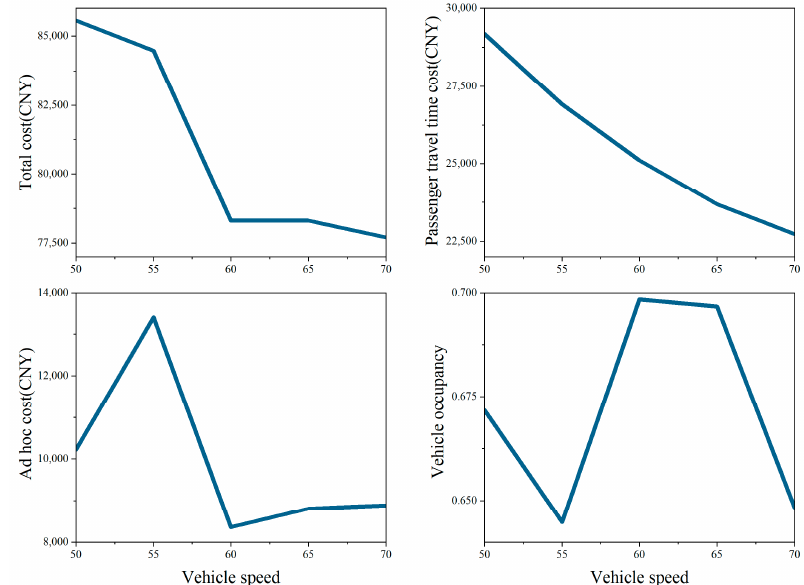
Figure 15. Sensitivity analysis of vehicle speed in Shenzhen airport.